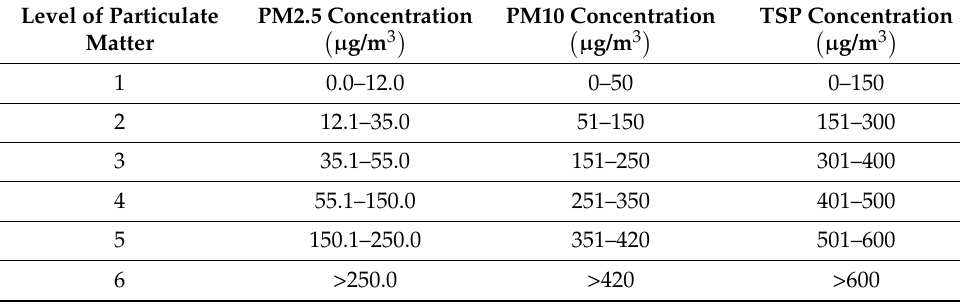
Table 9. Classification of particulate matter.